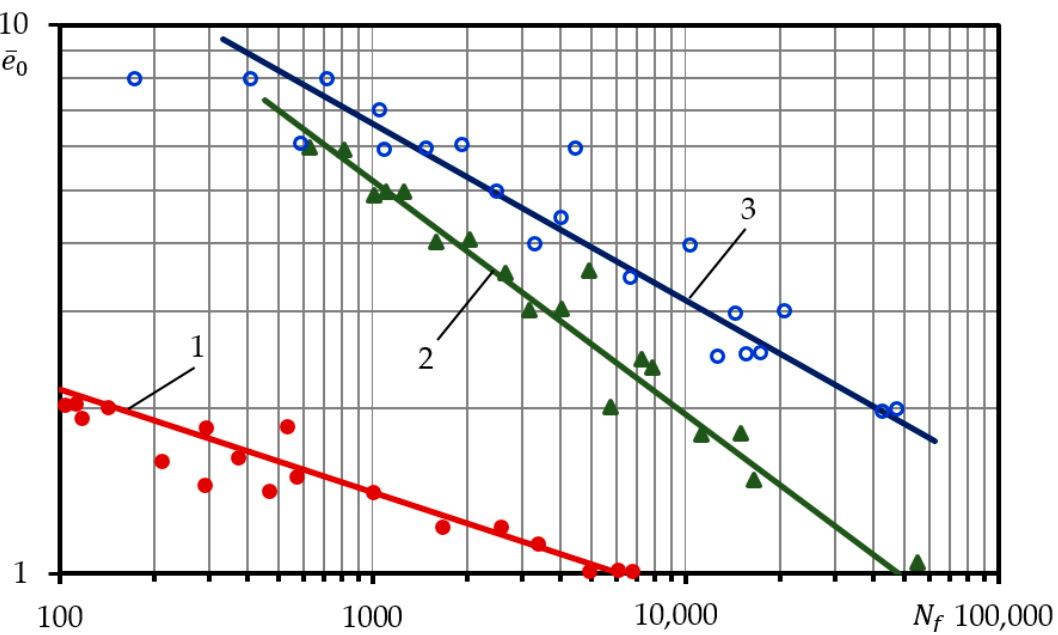
Figure 2. Low cycle fatigue durability curves under strain-controlled loading: 1—aluminium alloy D16T, 2—alloyed steel 15Cr2MoVA, 3—structural steel C45.